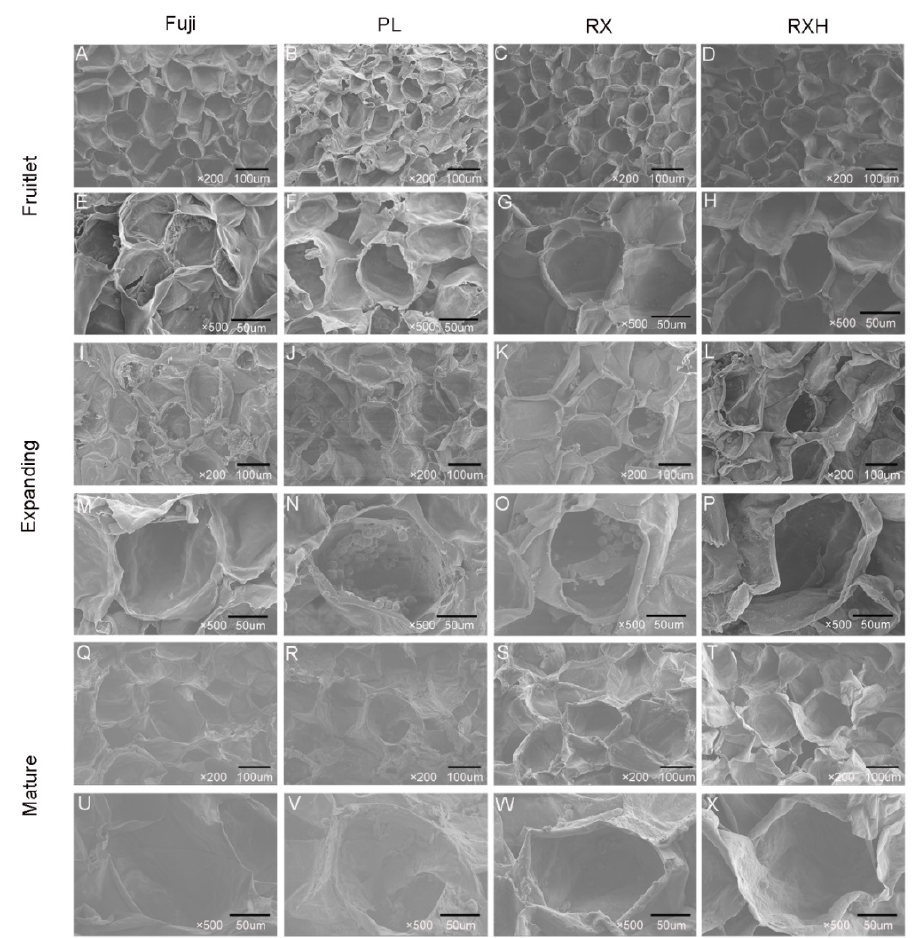
Figure 5. Scanning electron micrograms showing tissue fracture patterns during ripening progress of different cultivars of apple fruit. ( A – D , I – L , Q – T ) were obtained at 200 × magnification (bar, 100 mm), and ( E – H , M – P , U – X ) were obtained at 500 × magnification (bar, 50 μ m).